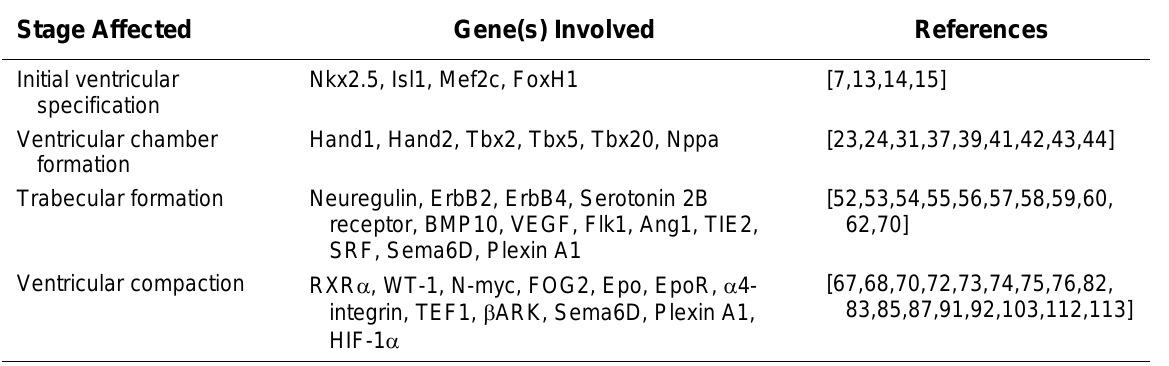
Examples of Genes Involved in Key Stages of Ventricular